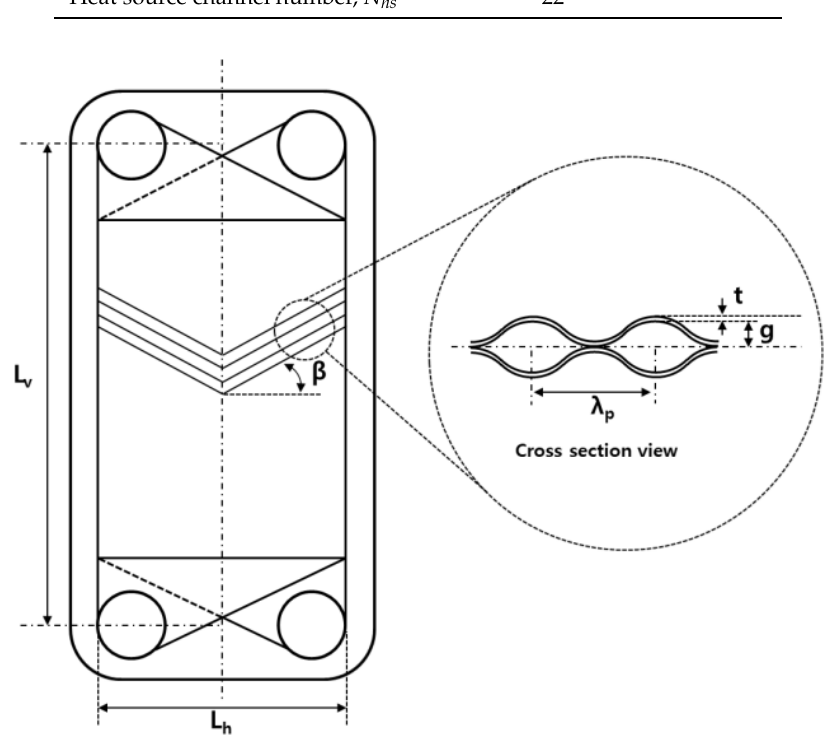
Figure 4. Basic geometric characteristics of chevron plate heat exchanger. Table 3. Operating parameters of the chevron plate heat exchanger.